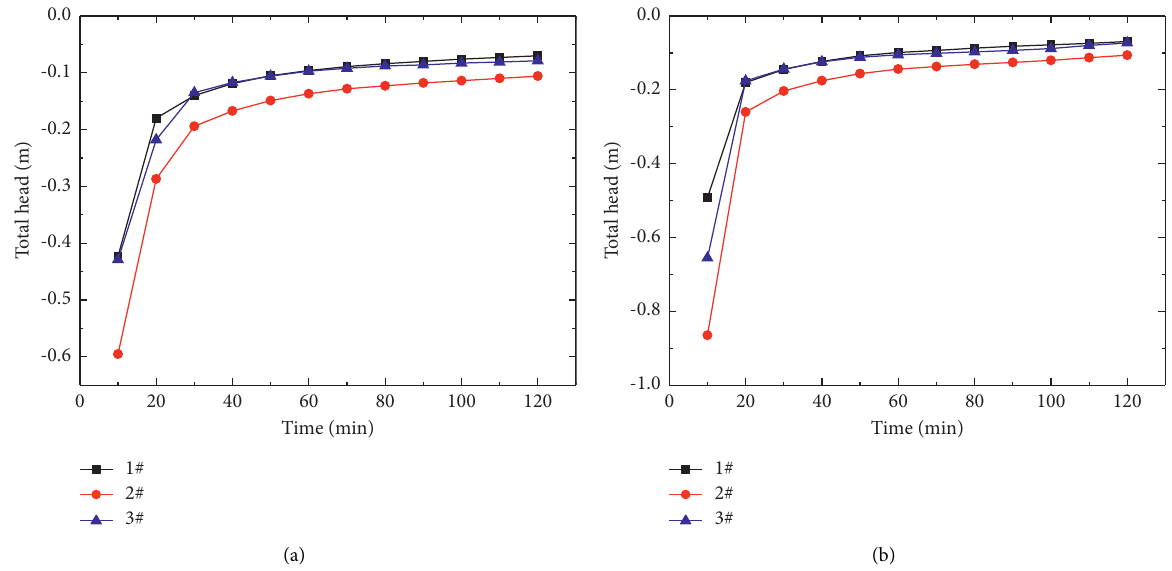
Figure 30: Total head at observation points 1–3 of (a) buildings 1–2 and (b) buildings 2–4 with seepage wells placed around buildings 1 and 2 in the numerical model.